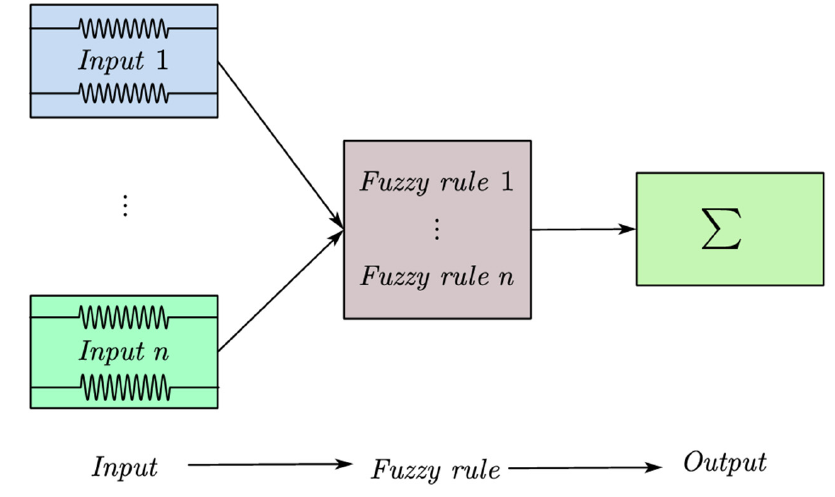
Figure 3. ANFIS framework of a single evaluation index.